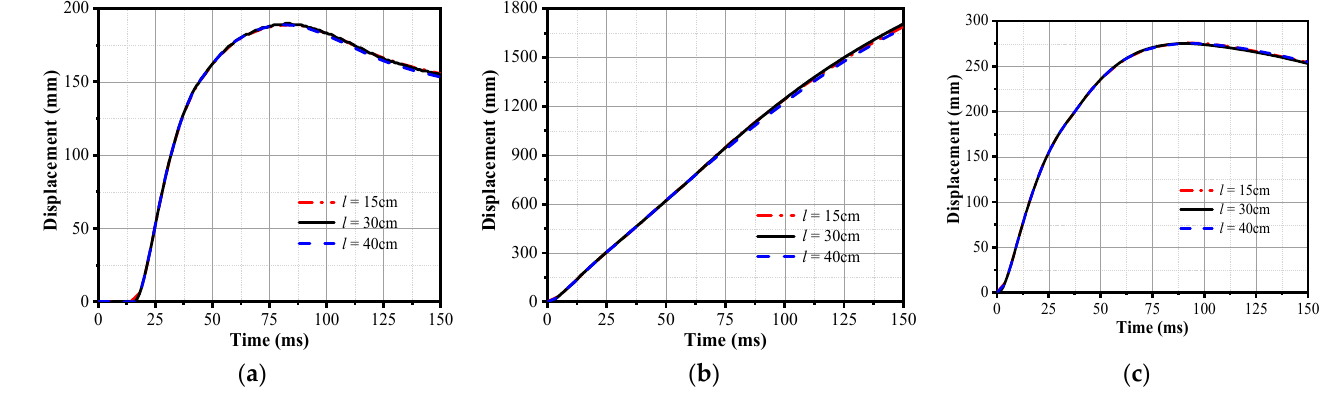
Figure 17. Influence of anchorage length to wall center displacement-time histories: ( a ) Load 1; ( b ) Load 2; ( c ) Load 3.